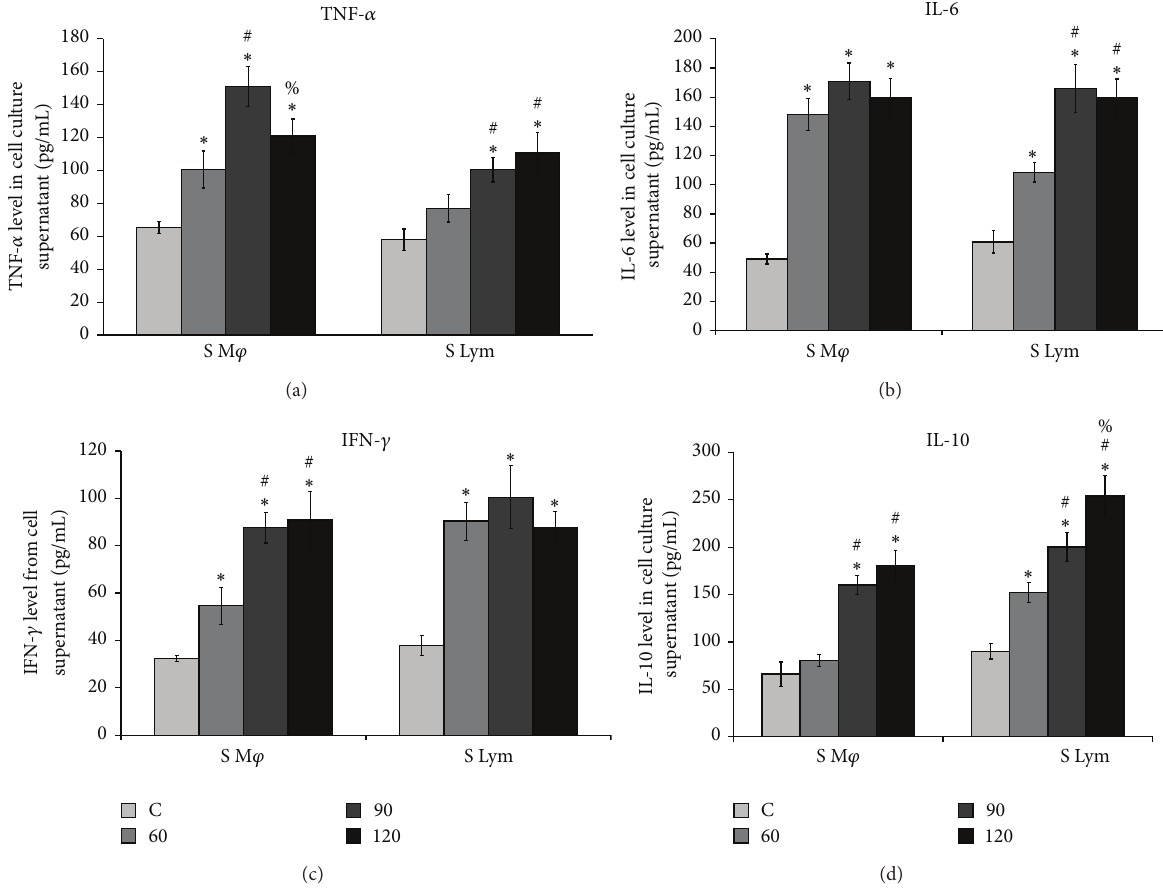
Figure 6: Analysis of cytokines from the cell culture supernatant of splenic macrophages and lymphocytes after in vitro LPS stimulation. Levels of (a) TNF- 𝛼 ; (b) IL-6; (c) IFN- 𝛾 ; and (d) IL-10 in the supernatant of untreated and LPS stimulated splenic macrophages at 60, 90, and 120 minutes after treatment showed time-dependent cytokine production after endotoxin stimulation (values are expressed as Mean ± SD from triplicate experiments and are significant ( 𝑃 < 0.05 ) from 6 mice in each group). The following symbols represent significant difference between: ∗ control versus LPS treated cells, # LPS treatment for 60 minutes versus LPS treatment for 90 and 120 minutes, % LPS treatment for 90 minutes versus LPS treatment for